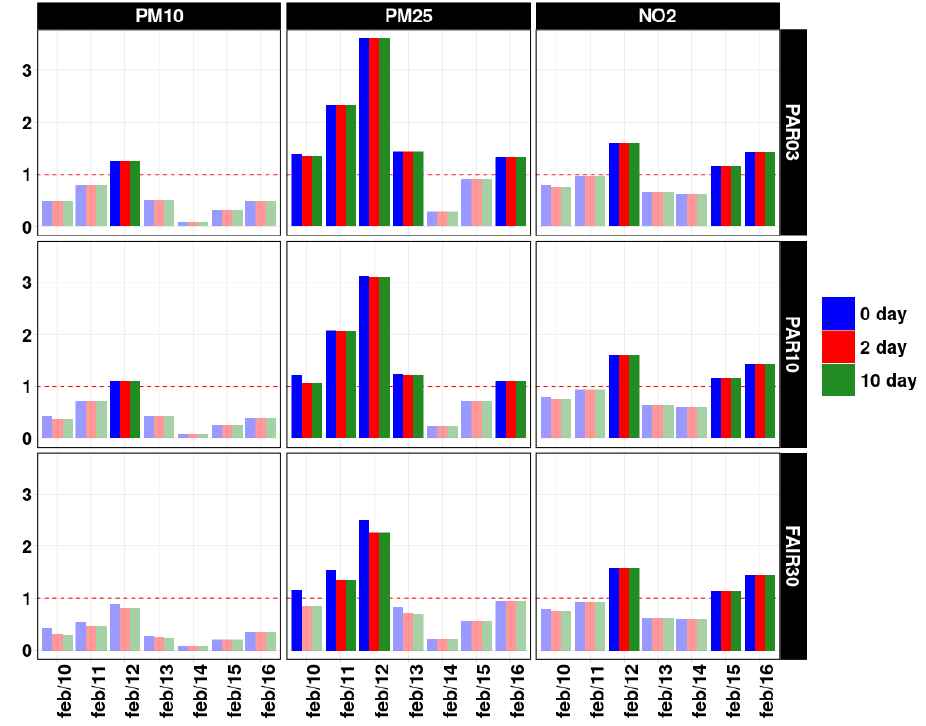
Figure 8. Ratio between simulation concentration and the WHO guidelines for species showing exceedances (PM 10 , PM 2.5 and NO 2 ) when reductions are applied to different domains (right panel) and for different starting times for the reductions (bars). The horizontal axis represents the day on which the reductions start (0day represents the 10th, 2day the 8th and 10day represents the 1st), the vertical axis represents the ratio. The red dashed line shows the limit for the guideline; above this line the concentration passes the guideline. For visual aide, bars with concentrations not higher than the guideline are shown in low transparency. Average over urban cells is shown